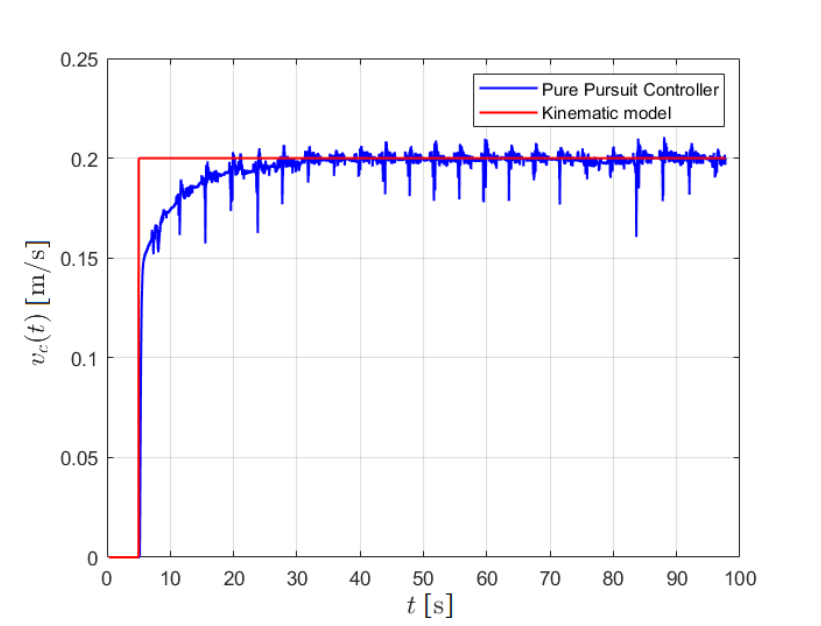
Figure 34. Linear velocity v c ( t ) of the